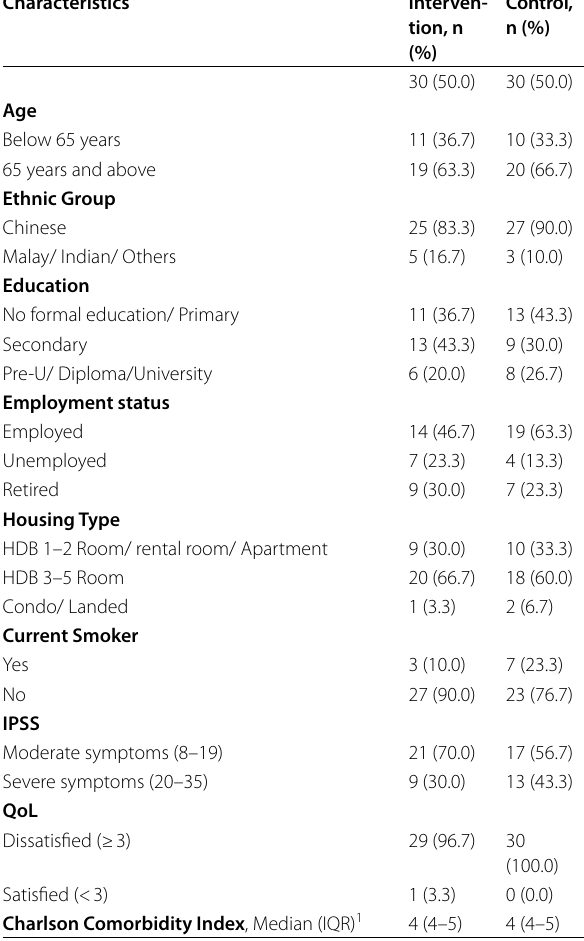
Table 1 Baseline characteristics of men by treatment group Characteristics